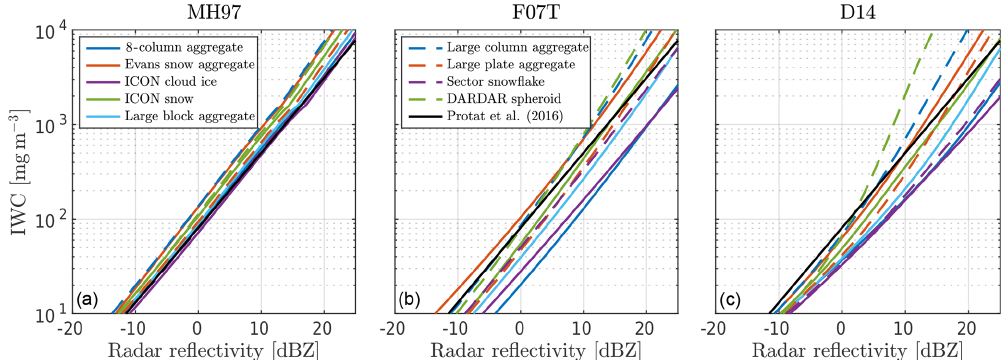
Figure 4. Radar reflectivity and IWC relationships at 255K. The coloured curves are the relationships obtained by combining the particle models in Table 1 with the particle size distributions of MH97 (a) , F07T (b) , and D14 (c) . The black lines represent the IWC–dBZ relationship taken from Protat et al.